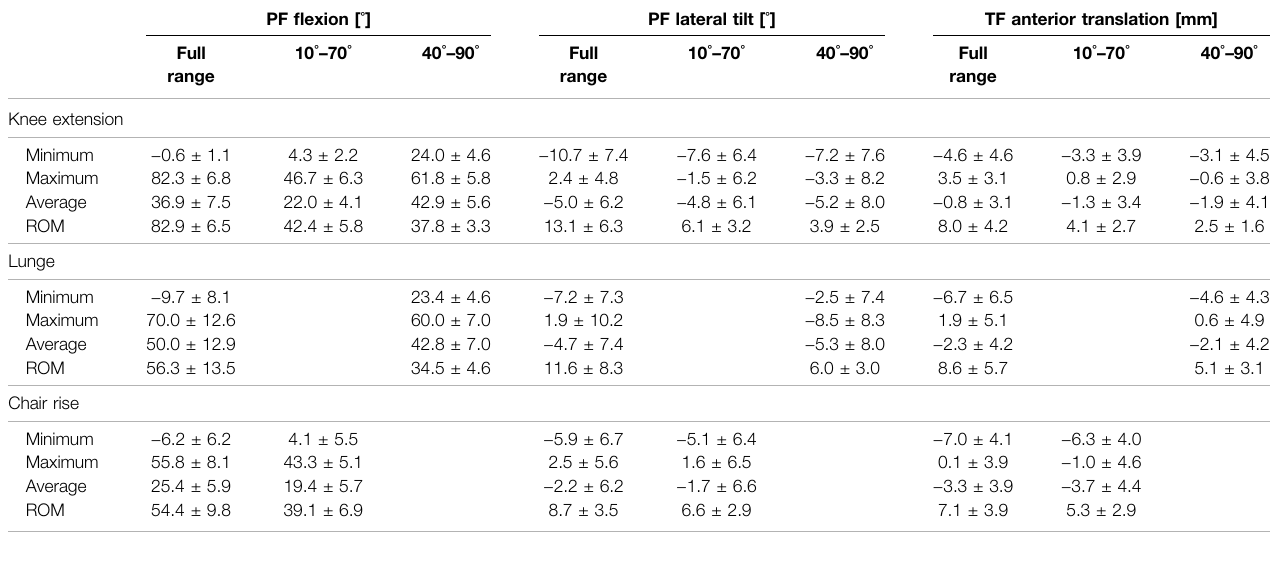
TABLE 3 | Minimum, maximum, average, and range of motion kinematics for the patella relative to the femur during knee extension, lunge, and chair rise. Kinematics is reported for the full range of knee fl exion, angle-matched fl exion range from 10 ° to 70 ° for comparison of knee extension to chair rise, and angle-matched fl exion range from 40 ° to 90 ° for comparison of knee extension to lunge.